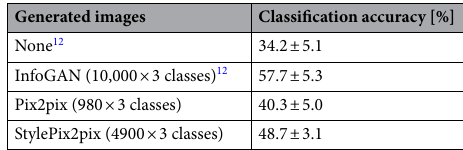
Table 3. Classification